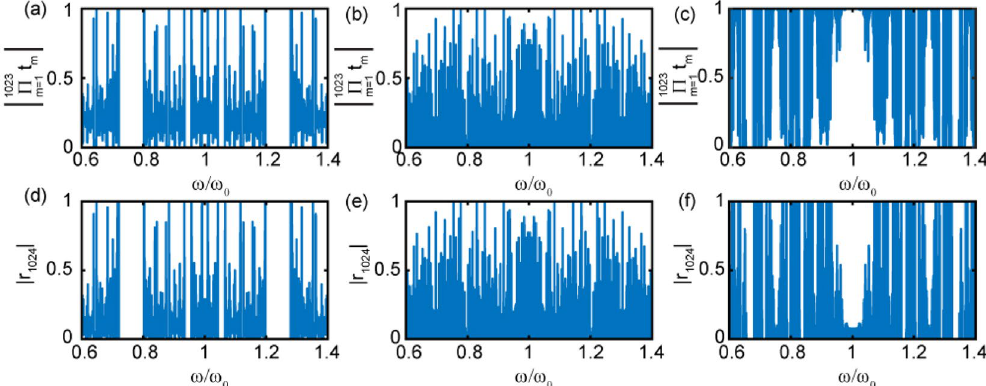
Figure 6. Net transmission ( a–c ) and reflection ( d–f ) spectrum defined using equations (8) and (9) respectively in the middle layer of the samples investigated in the main text. Each structure has 2048 layers and the panels display the net reflection and transmission values at the 1024 th layer. ( a , d ) Correspond to Fibonacci multilayers with n 1 = 1.5 and n 2 = 1.9. ( b , e ) Correspond to Rudin-Shapiro multilayers with n 1 = 1.5 and n 2 = 1.75 and ( c ), ( f ) correspond to the Thue-Morse multilayers with n 1 = 1.5 and n 2 =